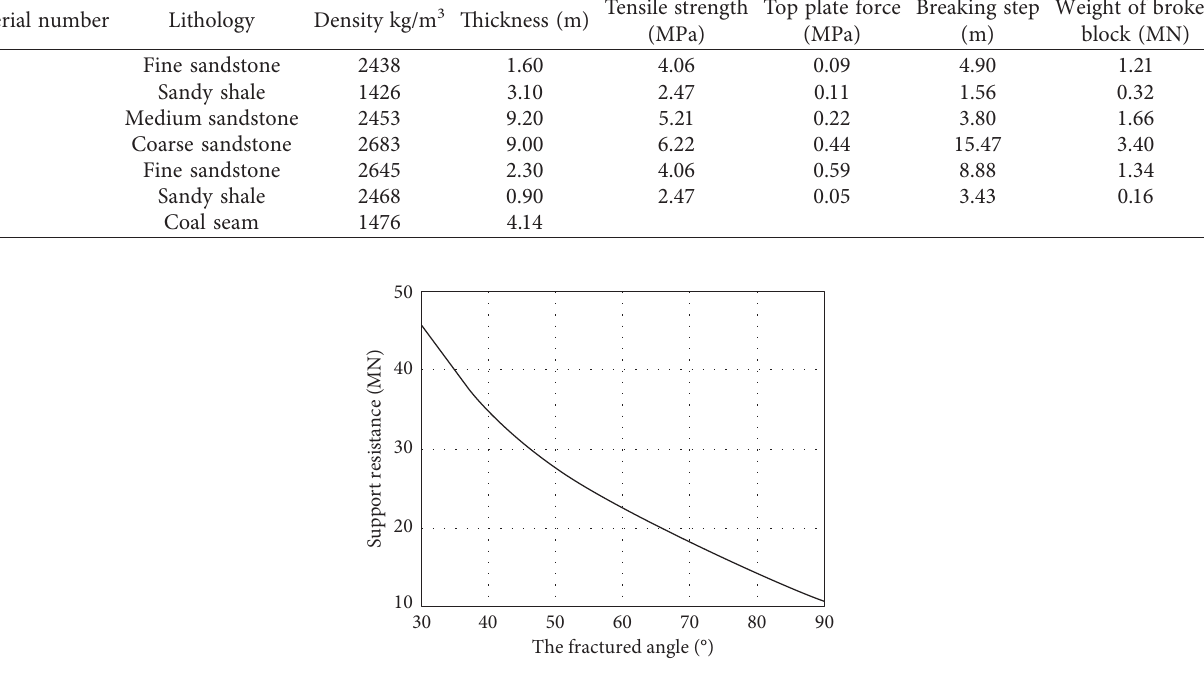
Figure 13: The relationship of stent resistance and the roof fracture angle of combination cantilever ( c � 5.5m). Table 5: The physical and mechanical characteristics of the nonhinged roof structure of No. 8218 large mining height working face.